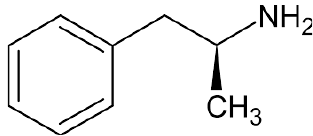
Figure 2. Chemical structure of amphetamine. Formula: C 9 H 13 N.